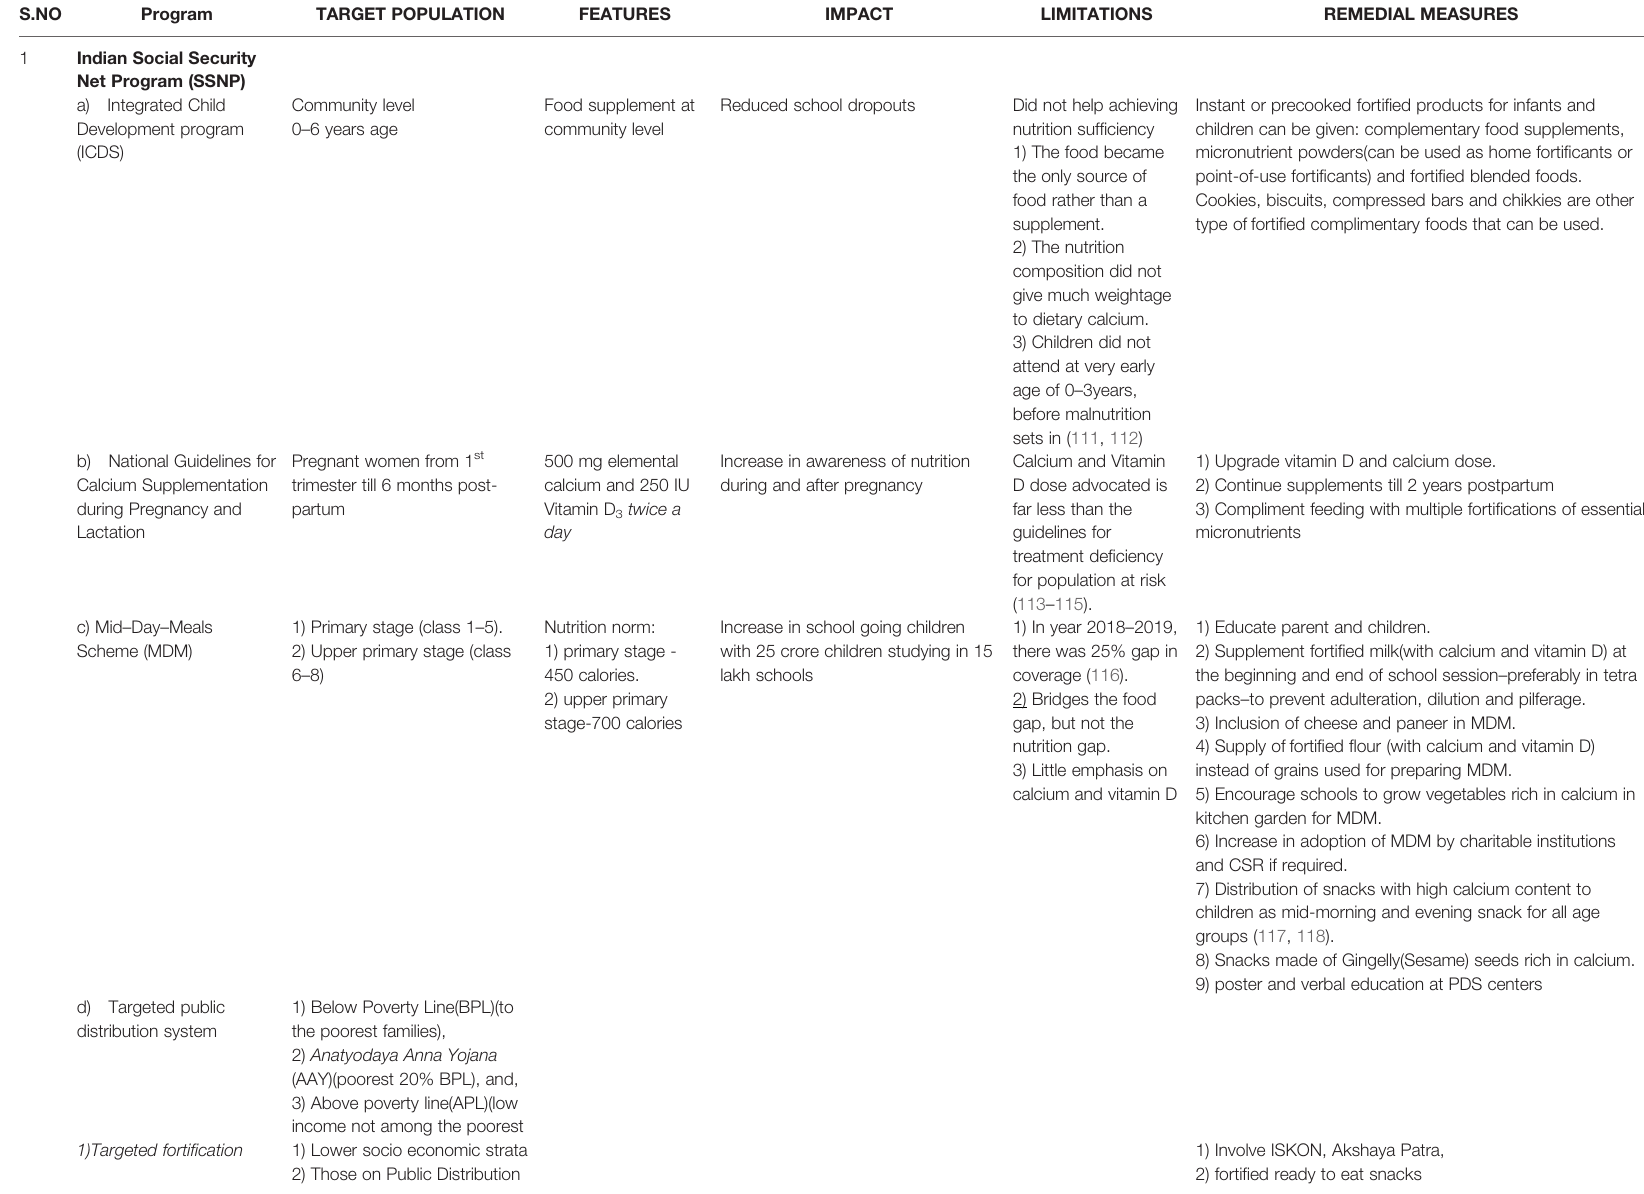
TABLE 4A | Table showing strategies to combat dietary calcium de fi ciency governmental and digital in rural and urban